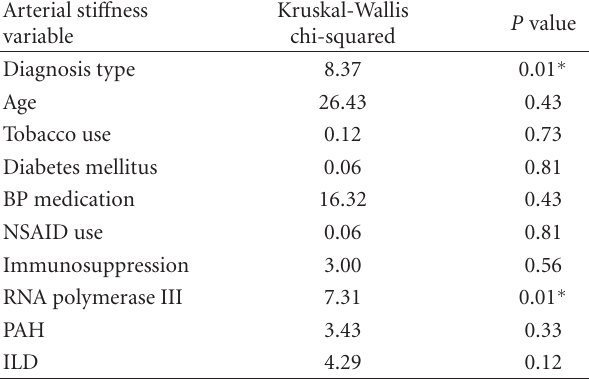
Table 1: Auscultatory gap association with possible arterial sti ff ness and vasculopathy variables in